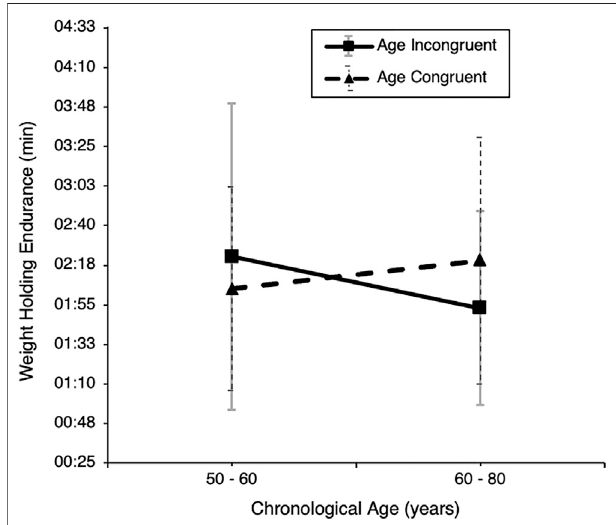
FIGURE 8 | Weight holding endurance of the older sample by experimental condition and median-split chronological age. Note. Weight holding endurance in minutes of older participants, displayed separately for the YA O (young avatar) and OA O (old avatar) subgroups with separate data points for (median split) chronological